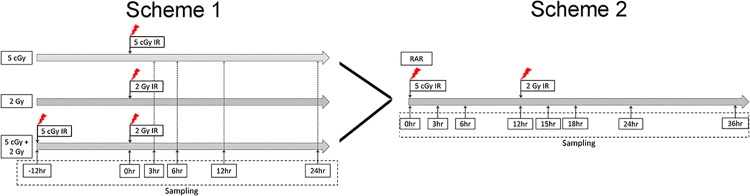
The microarray analysis timeline.